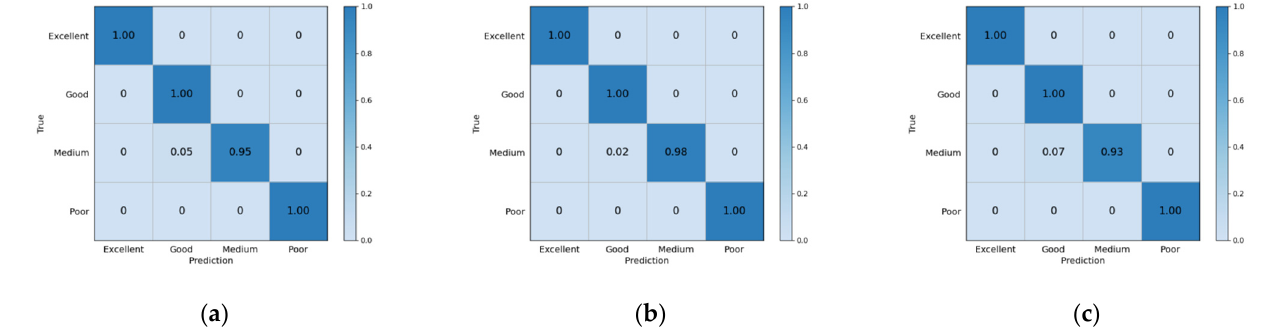
Figure 10. Confusion matrix for girls’ physical fitness level evaluation. ( a ) Confusion matrix when epoch is 250; ( b ) Confusion matrix when epoch is 300; ( c ) Confusion matrix when epoch is 350.